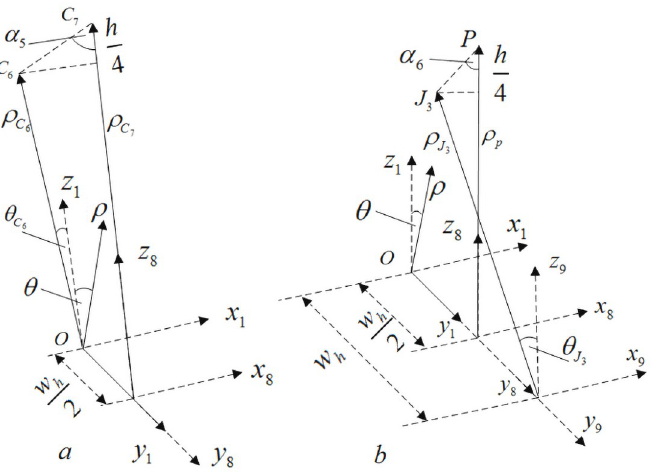
Fig 10. Calculation of braiding angle of internal cell